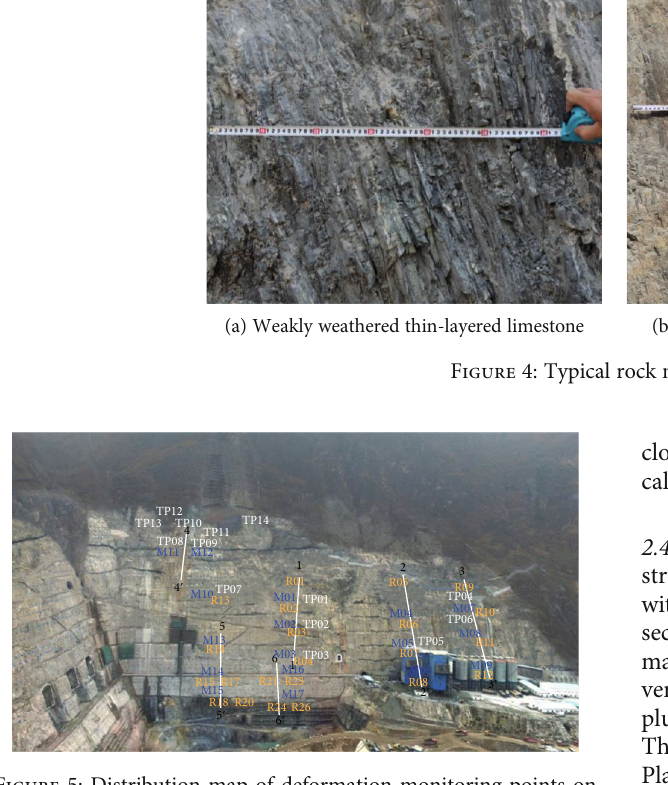
Figure 5: Distribution map of deformation monitoring points on the